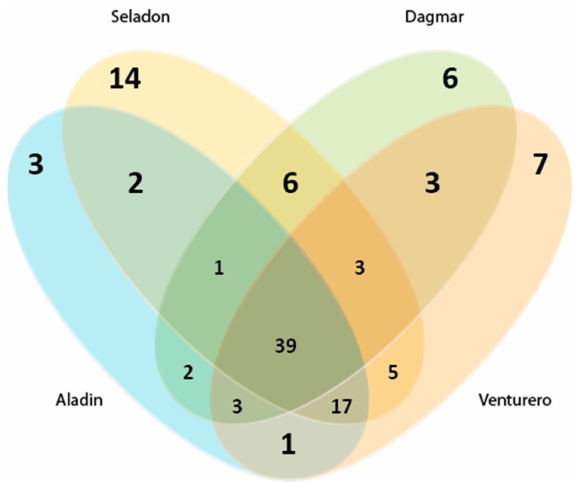
Figure 3. OTU distribution across the analyzed wheat varieties. Venn diagram showing the number of operational taxonomic units (OTUs) shared and unique among di ff erent wheat